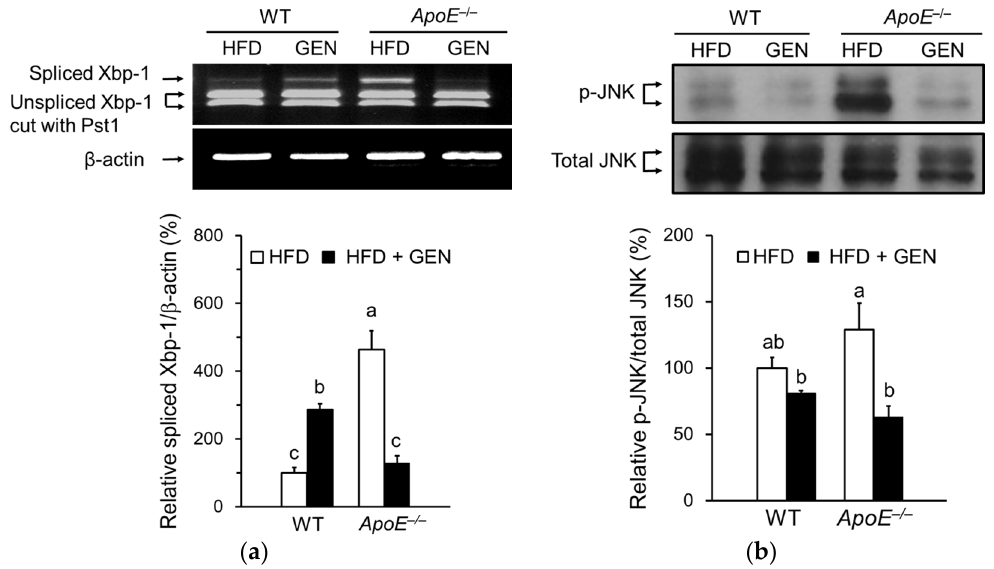
Figure 3. Effects of genistein on endoplasmic reticulum (ER) stress in the cortex and hippocampus of WT and ApoE − / − mice fed an HFD. ( a ) Relative mRNA expressions of X ‐ box ‐ protein ‐ 1 (Xbp ‐ 1) spliced form were analyzed by semiquantitative PCR and normalized to beta ‐ actin ( n = 3); ( b ) relative protein levels of phosphorylated c ‐ Jun N ‐ terminal kinase (p ‐ JNK) were analyzed by immunoblotting and were normalized to total JNK ( n = 3). Each bar represents the mean ± SEM and bars with different superscripts are significantly different at p < 0.05.